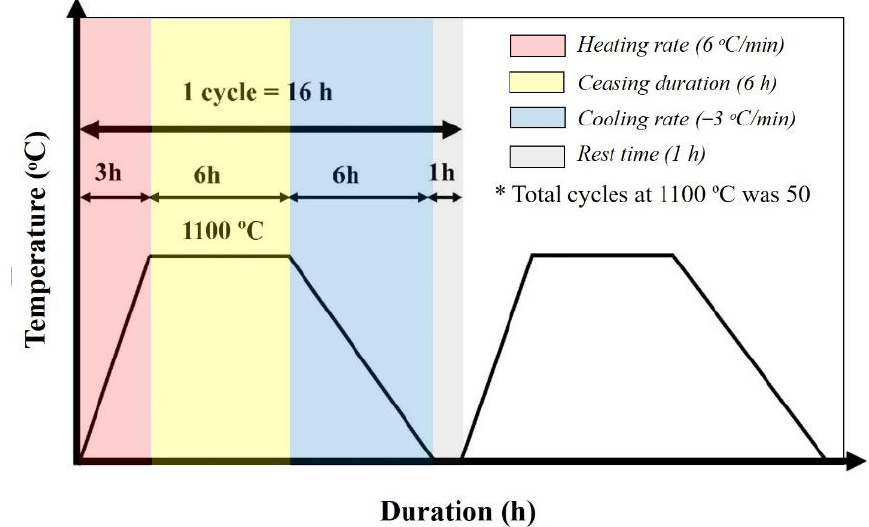
Figure 2. The hot cyclic oxidation test diagram that was carried out on coated samples.